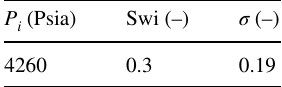
Table 11 Well input data of